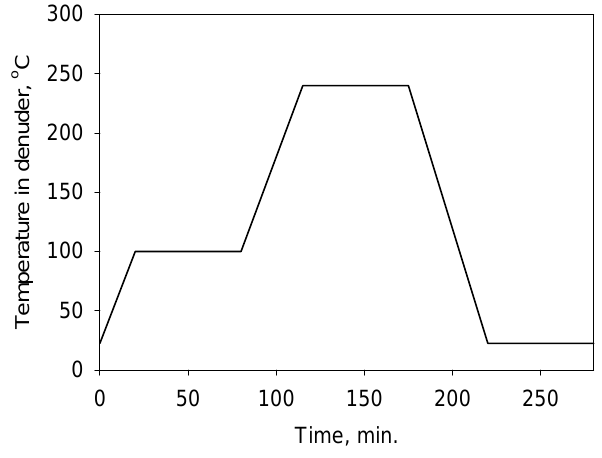
Fig. 1. Variation of temperature of the thermodenuder in TSMPS measurements.